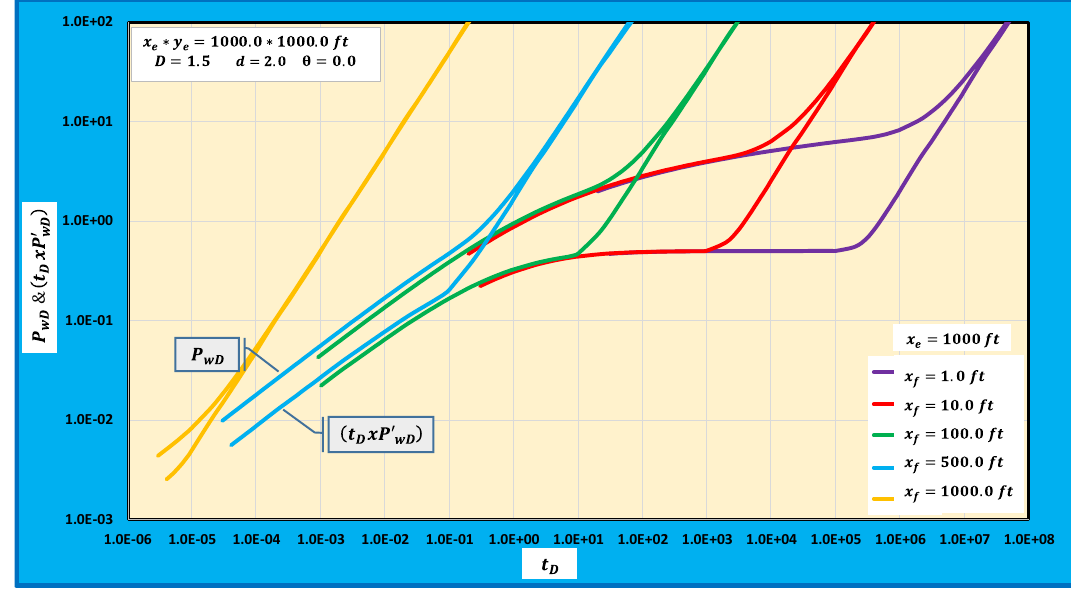
Fig. 10 Wellbore pressure and pressure derivative of different hydraulic fracture for developing bi-linear flow regimes and hydraulic fracture linear flow regimes as it is indicated by the red, green, and light blue color curves in Fig. 10. While using a hydrau- lic fracture half-length equals the distance to the reservoir boundary exists in the reservoir, causes developing the bi-linear flow